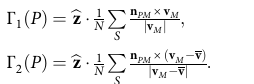
Fig. 4 Visualization of the numerical simulation. a Snapshot of the simulation at t ≈ 93 s. Vertical lines are magnetic fi eld lines of the fl ux tube, with colours denoting the strength of the local rotating speed v r . Red-white vertical backgrounds represent the background plasma density in the simulation. The bottom layer shows part of the SOT FG-blue photospheric intensity observations at 06:03:04 UT when a swirl was detected at the centre of the layer in the intergranular lane. b – d are the time-distance plots of a perpendicular slit along the z direction located close to the tube centre. v z and δ B a represent the z -direction velocity perturbation and azimuthal magnetic fi eld perturbation, respectively. We fi nd three different pulse fronts in the v z perturbation, and they travel at local sound (dash-dotted curve), Alfvén (solid curve) and tube (dashed curve) speed, respectively. However, only the Alfvén pulse causes both obvious perturbations in v r and δ B a . No wave train can be found because of the short life (20 s) of the driver. Source data of b – d are provided in